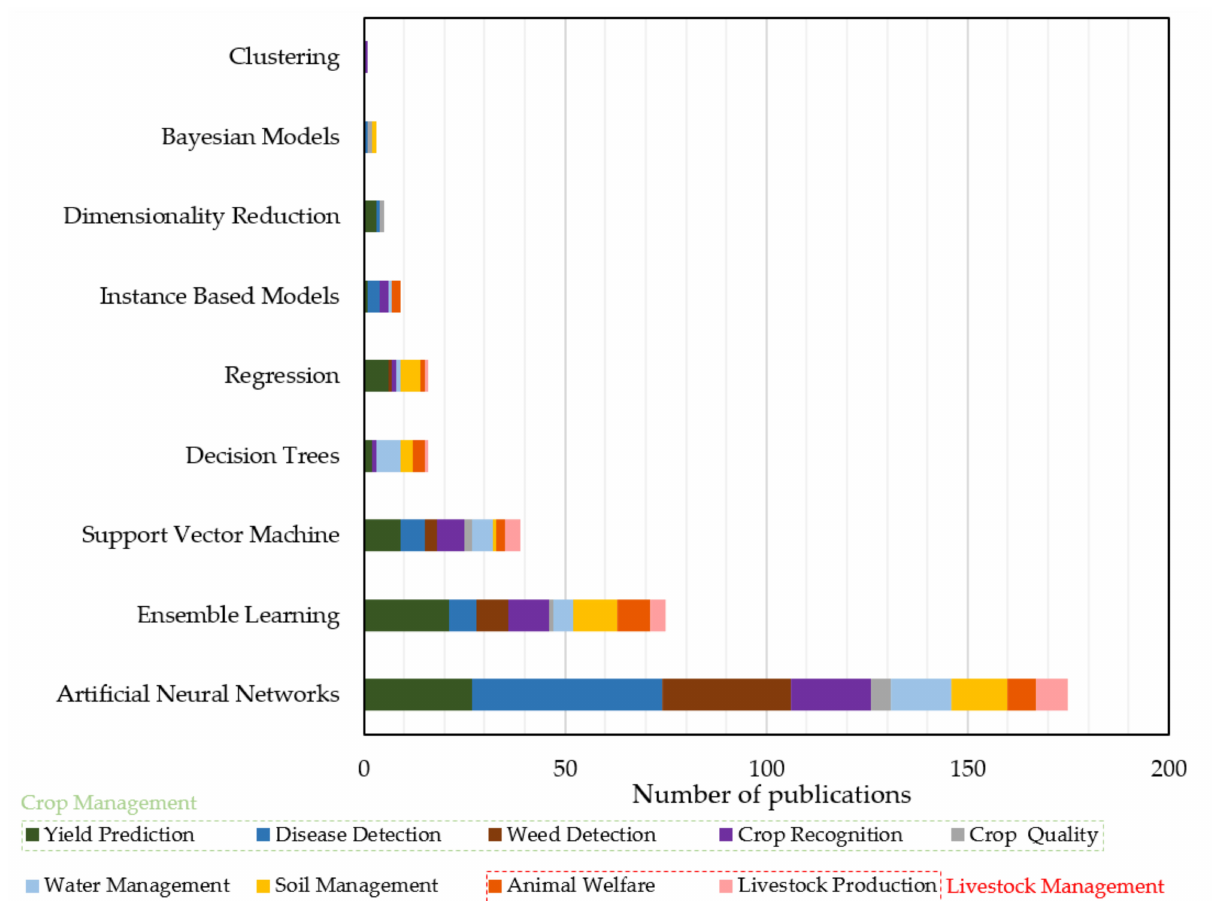
Figure 8. Machine Learning models giving the best